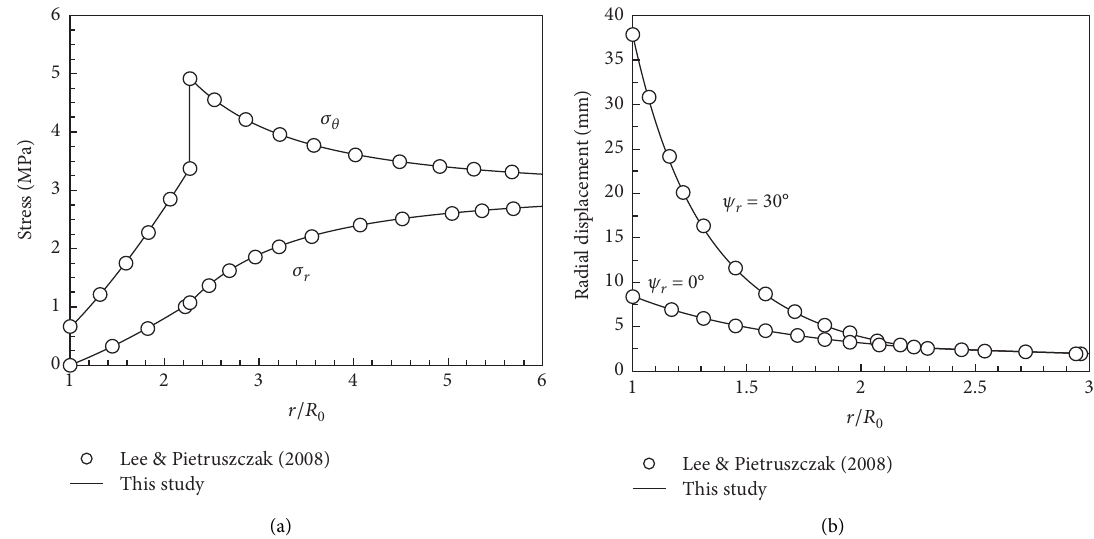
Figure 5: Comparison between this study and literature results. (a) Radial and tangential stress. (b) Radial